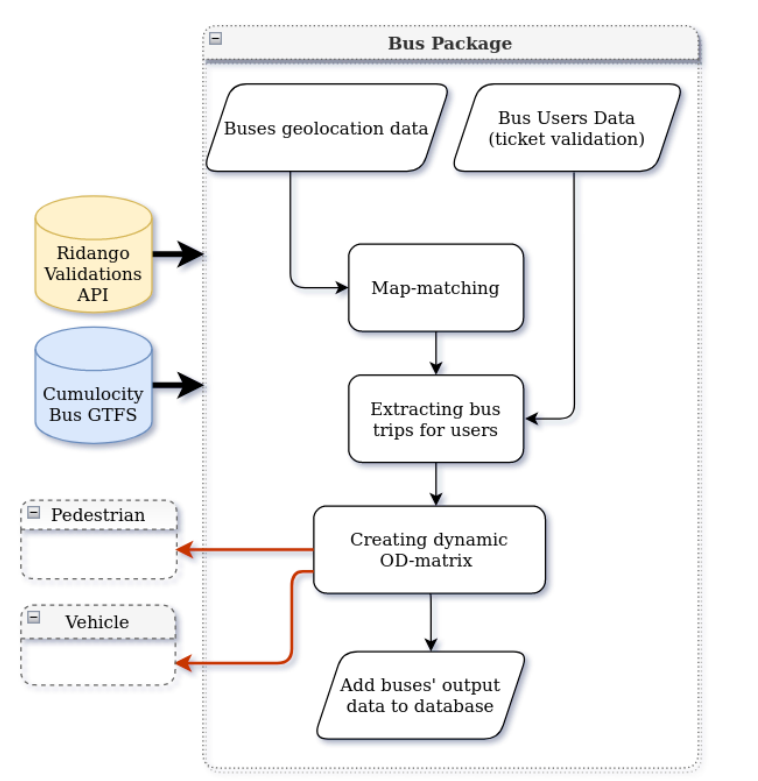
Figure 5. Bus package